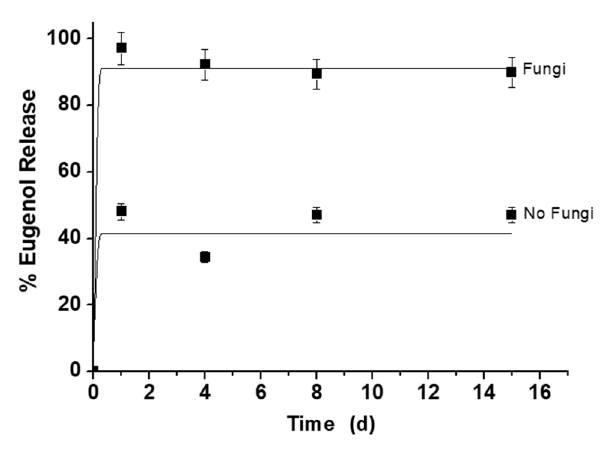
Figure 5. Kinetic release profile of eugenol from Maltodextrin-MSN-Eu in the absence and presence of fungi in the SPME assay after 15 d.